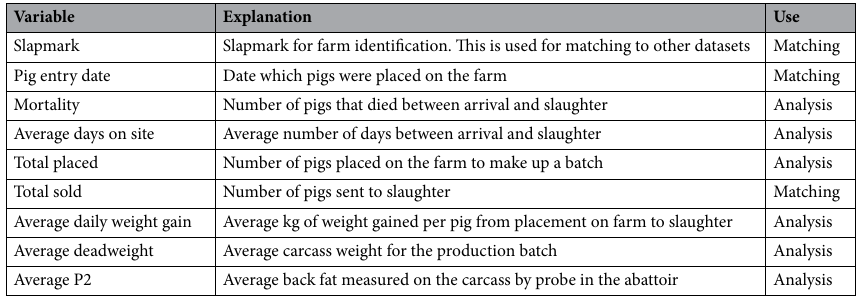
Table 1. Production batch data variable descriptions and an indication of whether these were used for data matching or data